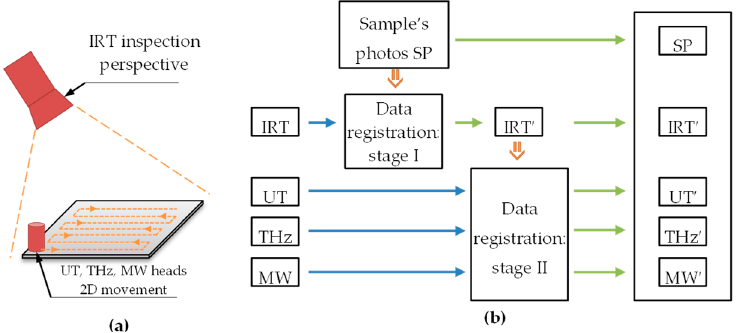
Figure 16. Schematic of the multiple inspections: ( a ) measurements setup, ( b ) diagram of multiple data compilation.